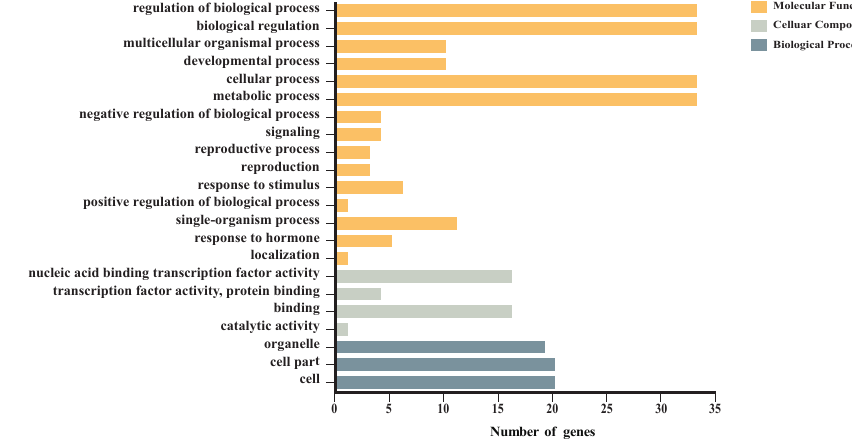
Figure 5. GO enrichment of CsaGRAS transcription factors in cucumber. According to the secondary terminology, the annotation results are divided into three ontology categories and distinguished by di ff erent colors.